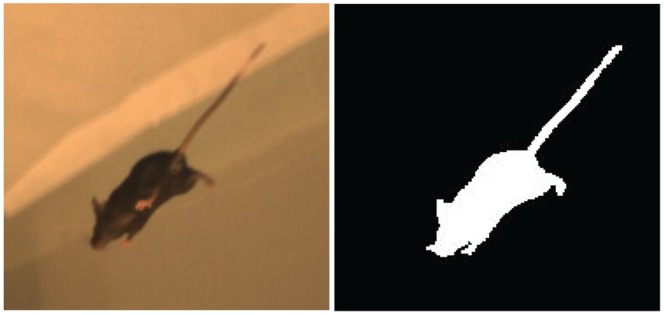
Image of a mouse (A) and silhouette of this mouse following background subtraction (B).Silhouettes from all 10 cameras were calculated and projected into the capture volume to define the 3D shape of the animal throughout the 2-minute, open-field trial.